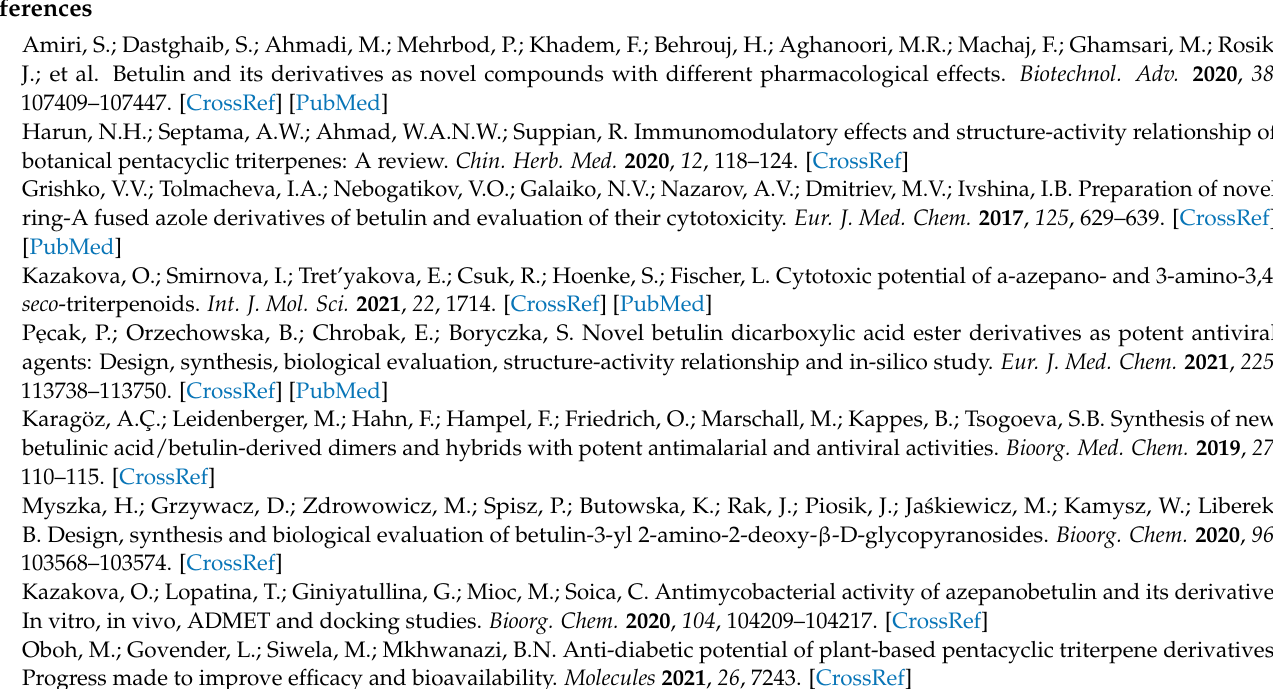
HR-MS for compounds 4 . Table S1: Selected bond lengths (Å) for compounds 4 . Table S2: Selected angle (degree) for compounds 4 . Figure S5: Atom by atom superimposition of X-ray structure (yellow) and calculate structure (grey). Figure S6: Intermolecular orientation of triazole and phenyl centroids showing π – π interactions. Figure S7: The full 2D fingerprint plot for 4 . check CIF